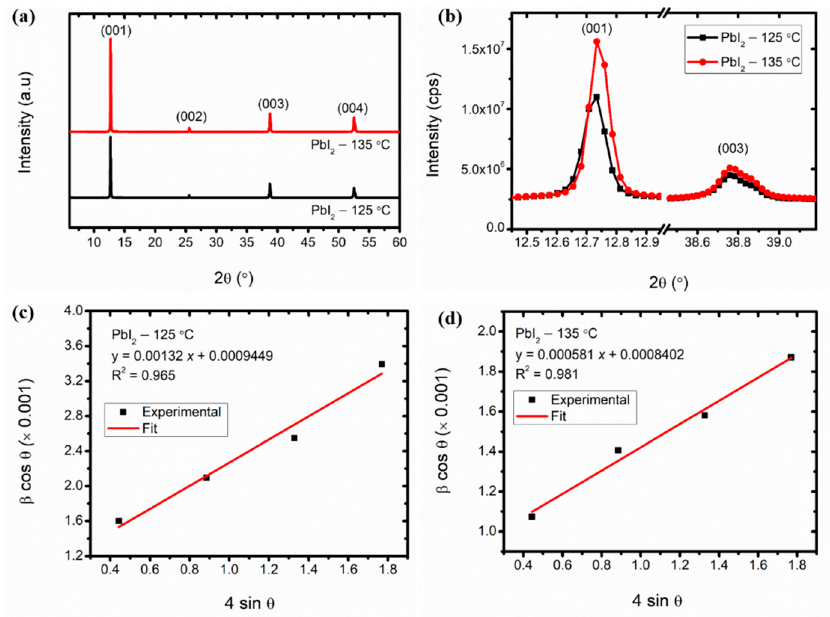
Figure 2. ( a ) Full XRD patterns of the PbI 2 thin films on glass deposited at different substrate temperatures; ( b ) zoomed XRD patterns showing the two intense (001) and (003) peaks of the PbI 2 films; ( c , d ) Williamson–Hall plots for crystallite size and strain estimation of the two PbI 2 films.